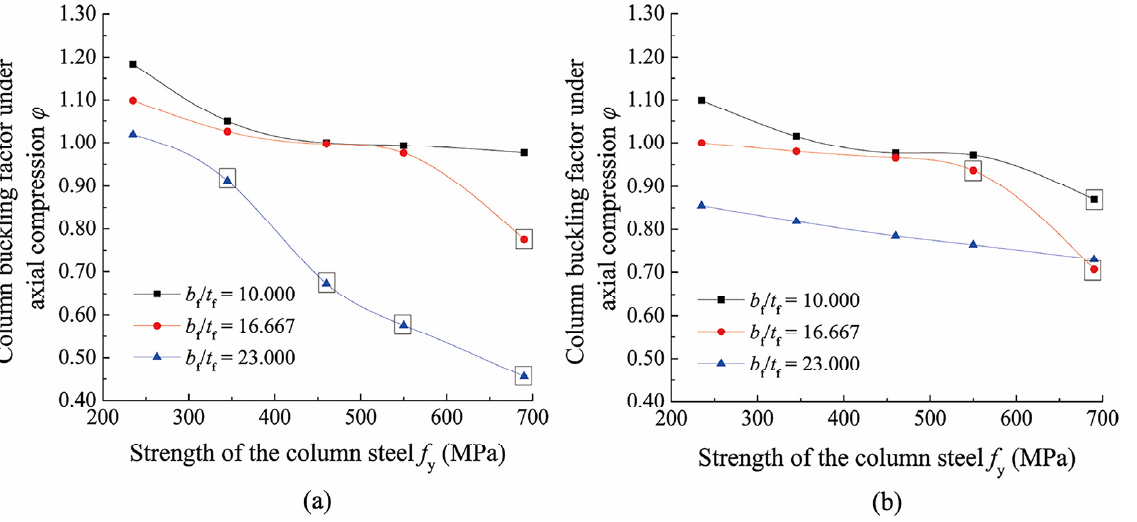
Figure 17. Relationship between column buckling factor and yield strength of column steel for varying flange width-to-thickness ratios: ( a ) Model M2- b f / t f , ( b ) Model M6- b f / t f .